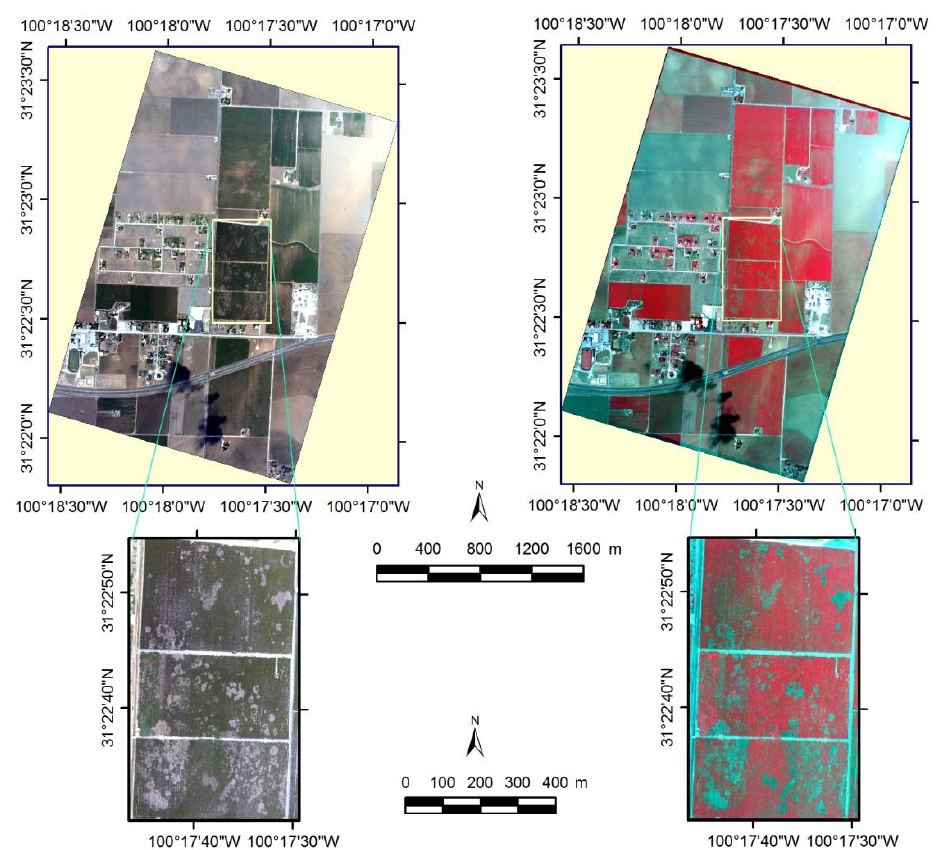
Figure 8. Normal color ( left ) and color-infrared ( right ) images acquired at 1524 m (5000 ft) AGL from a cotton root rot-infected area near San Angelo, Texas on 18 September